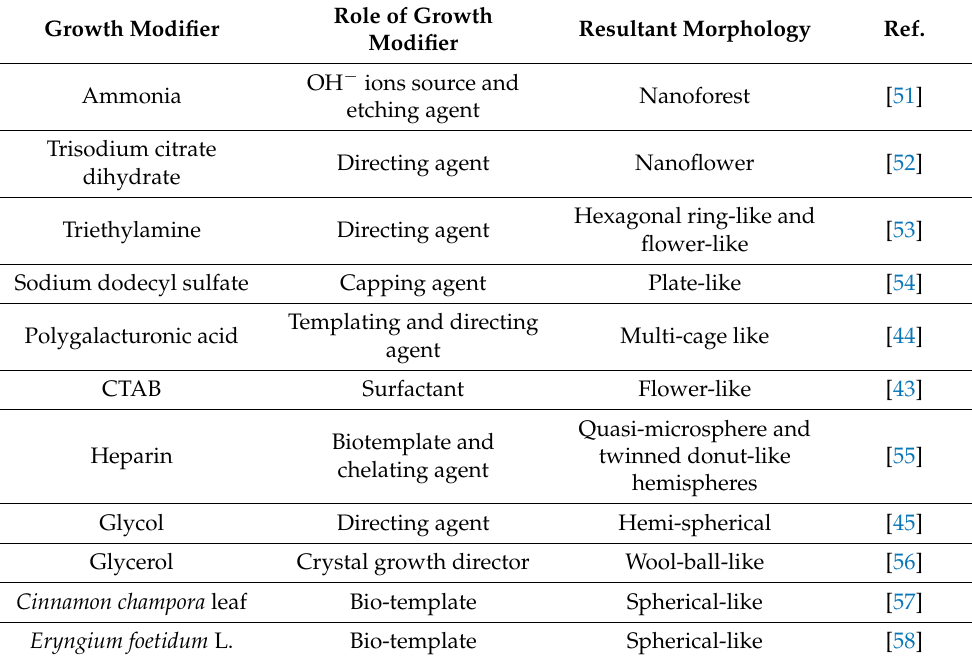
Table 2. List of different growth modifiers used for the synthesis of 3D-ZnO